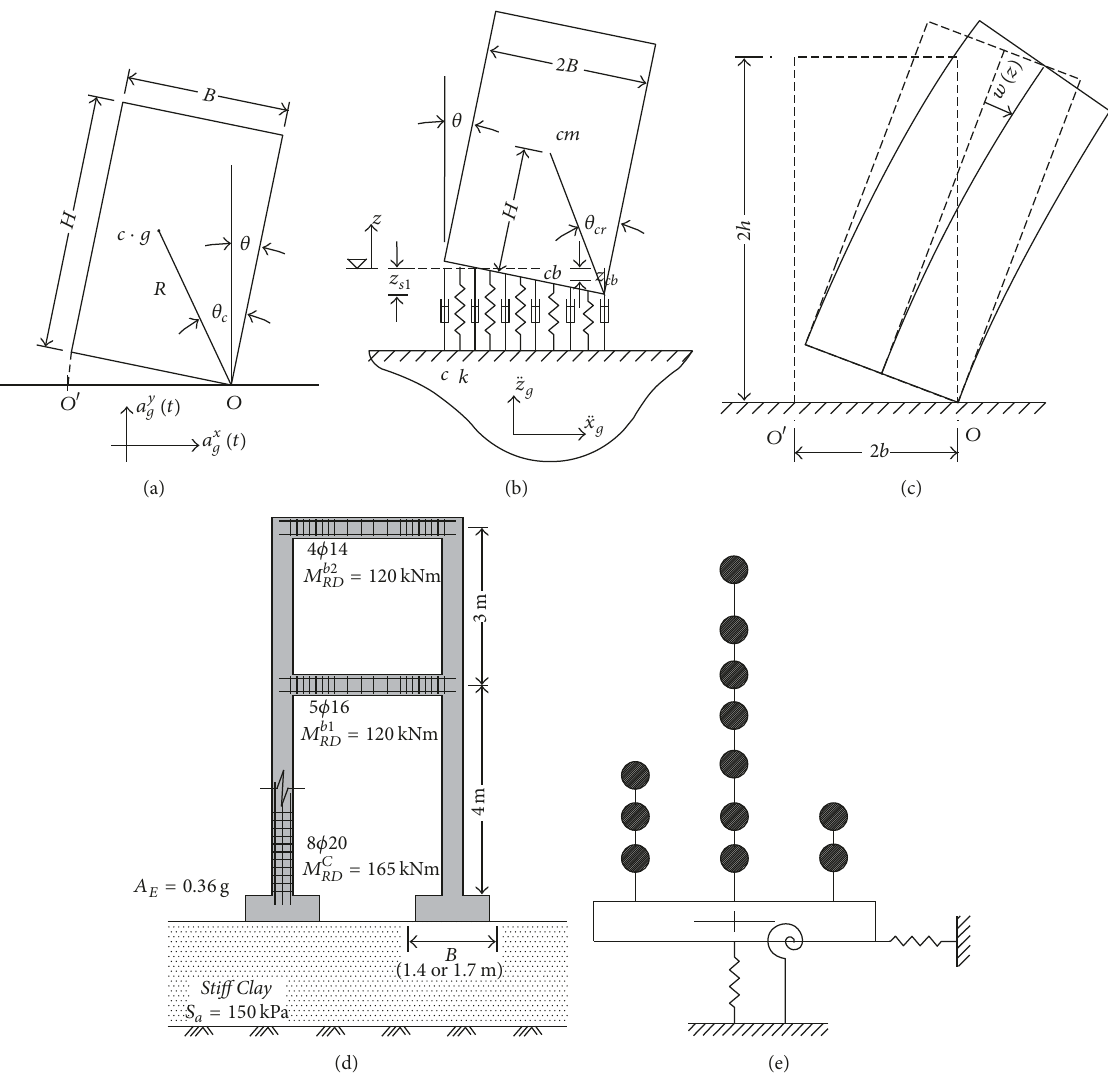
Figure 1: Four calculation models. (a) Rigid block rocking on rigid base [3]; (b) rigid block rocking on Winkler base [4]; (c) flexible block rocking on rigid base [6]; (d) practical structure rocking on elastic base [8]; (e) SR model